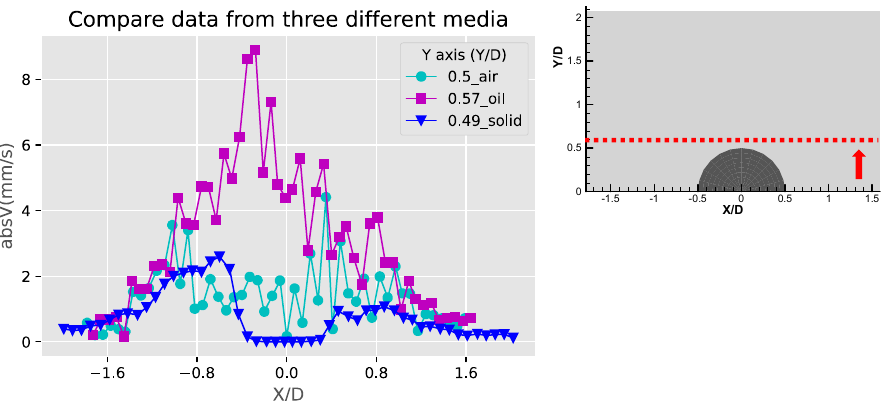
Figure 10. Comparison of the Y-component velocity (V) profiles at the top of the obstructions (Y/D = 0.5).